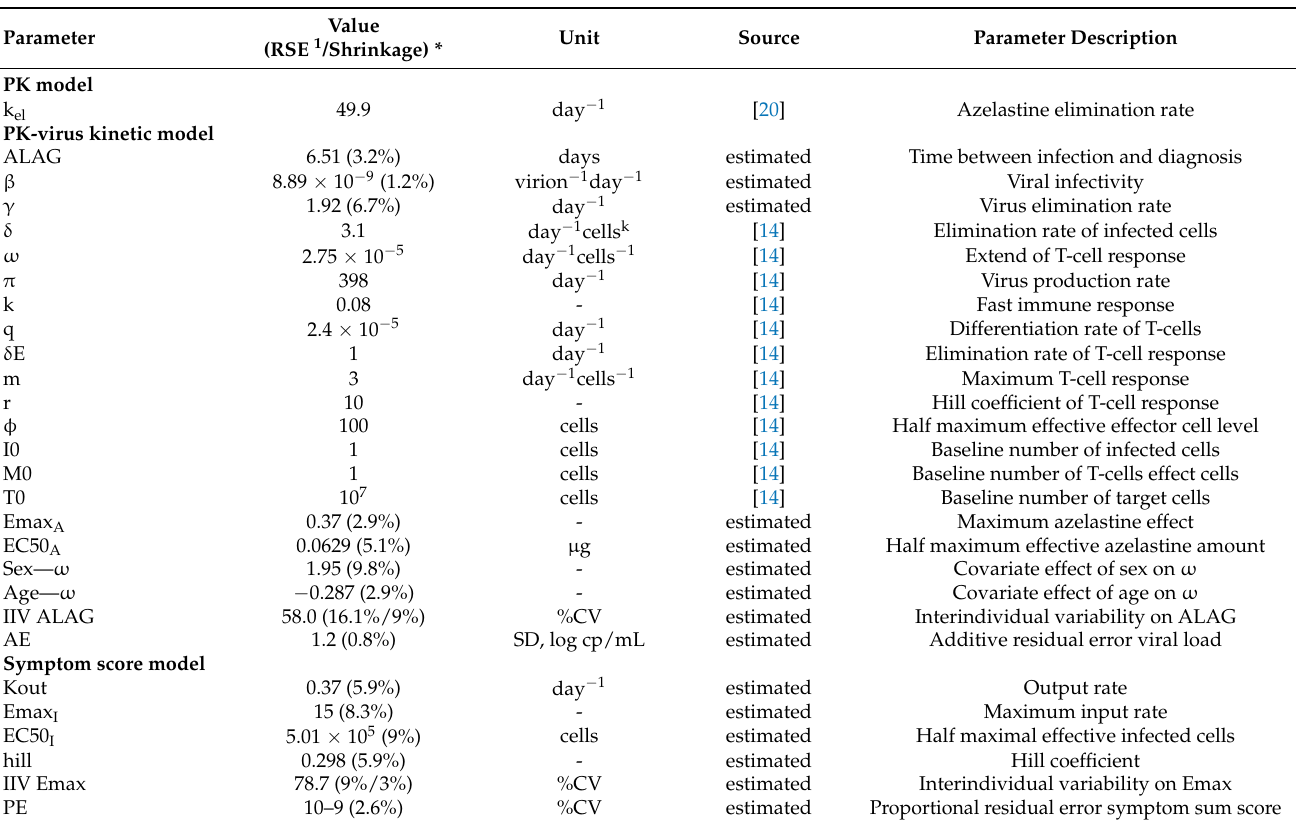
1 RSE: Relative standard error, * applicable for model parameter